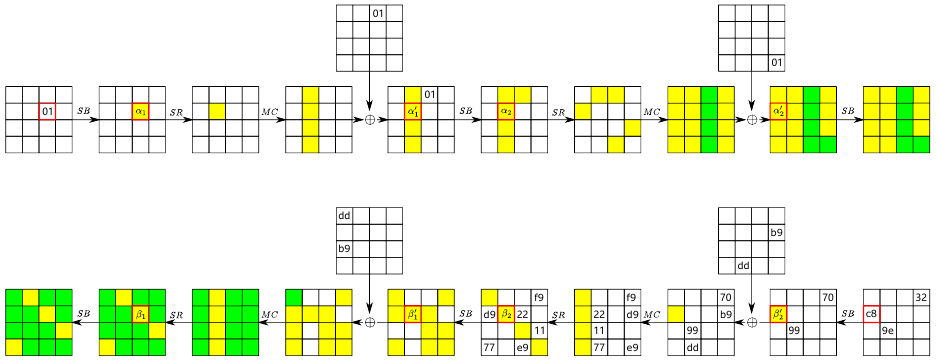
Figure 8: The three middle rounds of the 8-round boomerang attack in the model RTK1